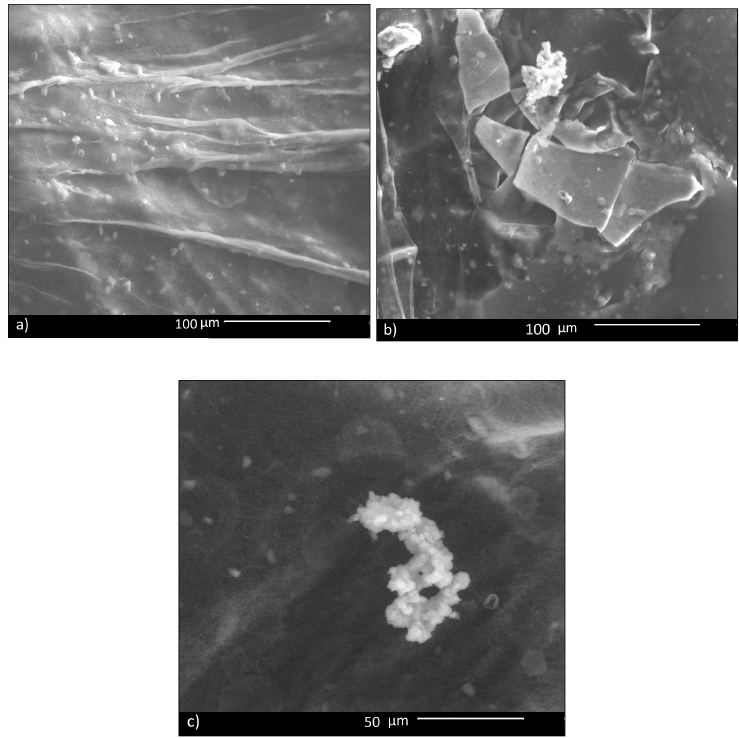
Figure 5. SBF test: 14 days after immersion of CHIT_PEO_BG10: in most parts, no HCA deposit is visible ( a ); in ( b , c ), a few isolated deposits are visible.